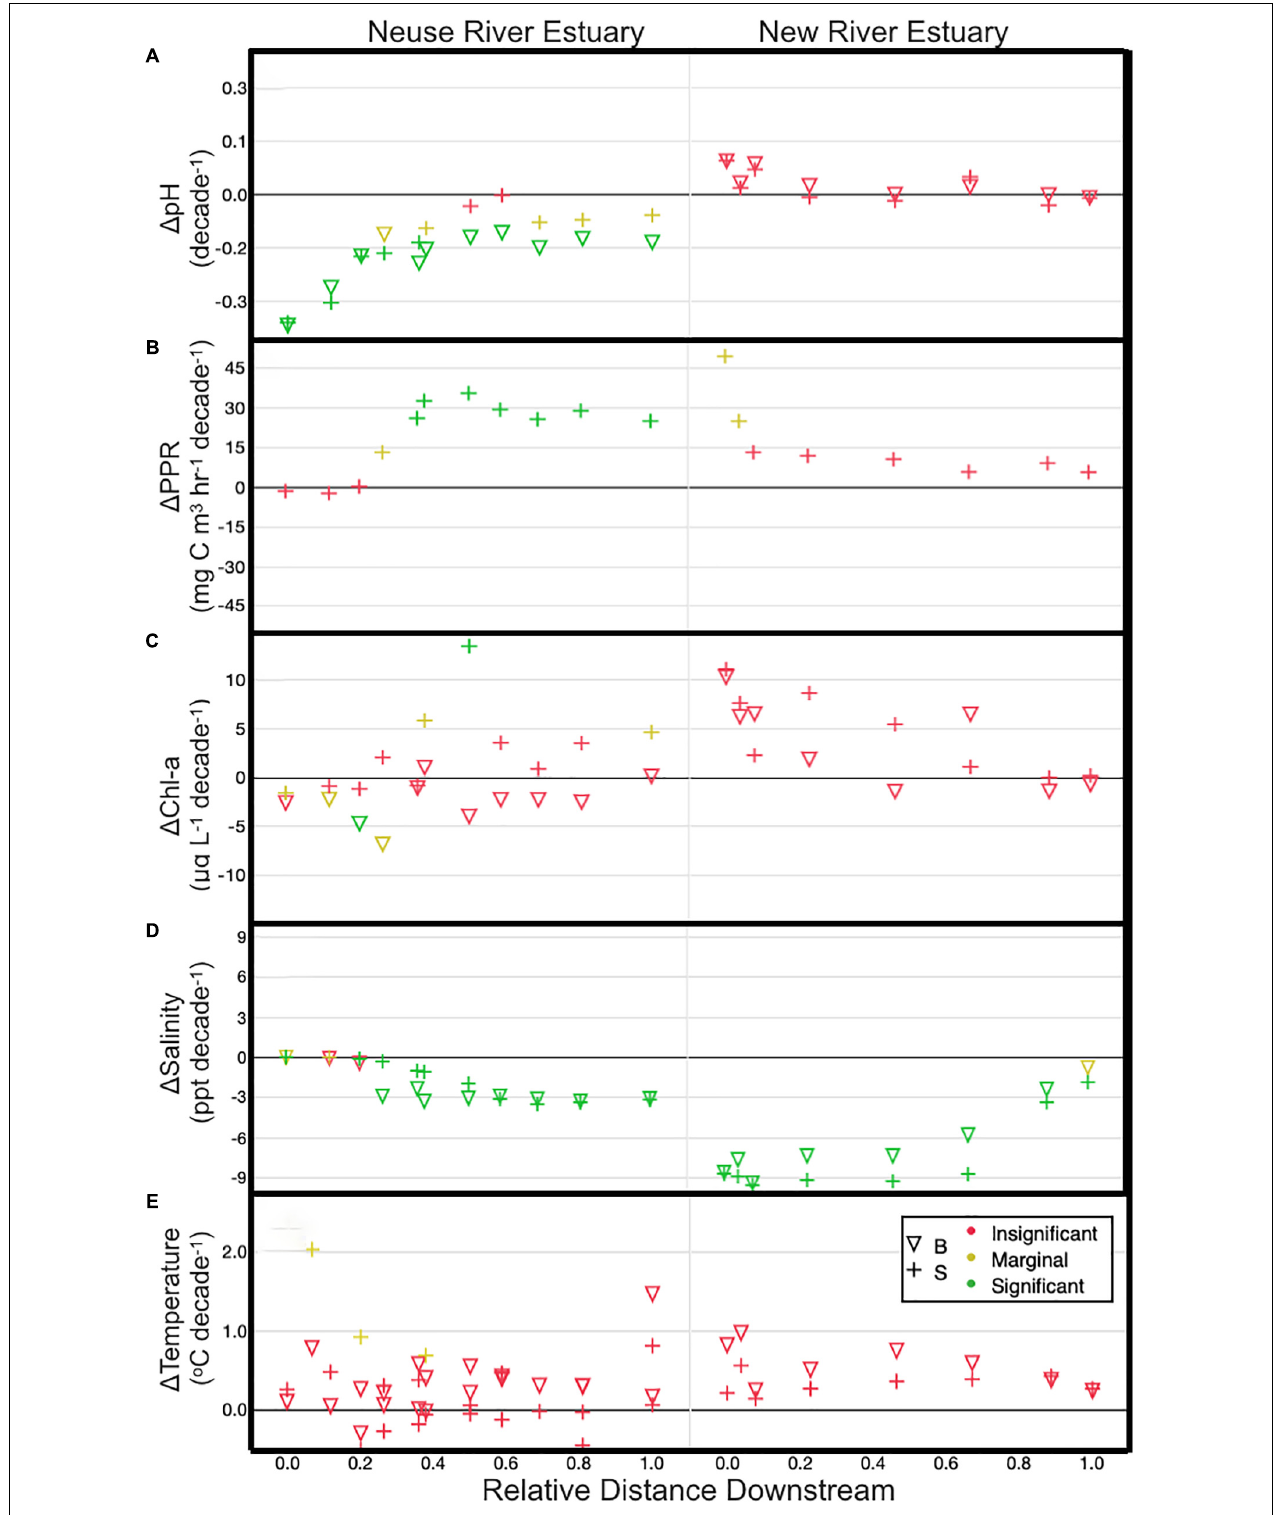
FIGURE 2 | Post-2005 trends for pH (A) , PPR (B) , Chl-a (C) , Salinity (D) , and Temperature (E) for surface (+) and bottom water ( ∇ ). Trends are shown relative to distance downstream, which is the distance from the head of the estuary divided by the total length of the estuary. Colors indicate the p -value for a t -test on the slope of the trend line (green: p < 0.01; yellow: 0.01 < p < 0.1; red: p > 0.1).